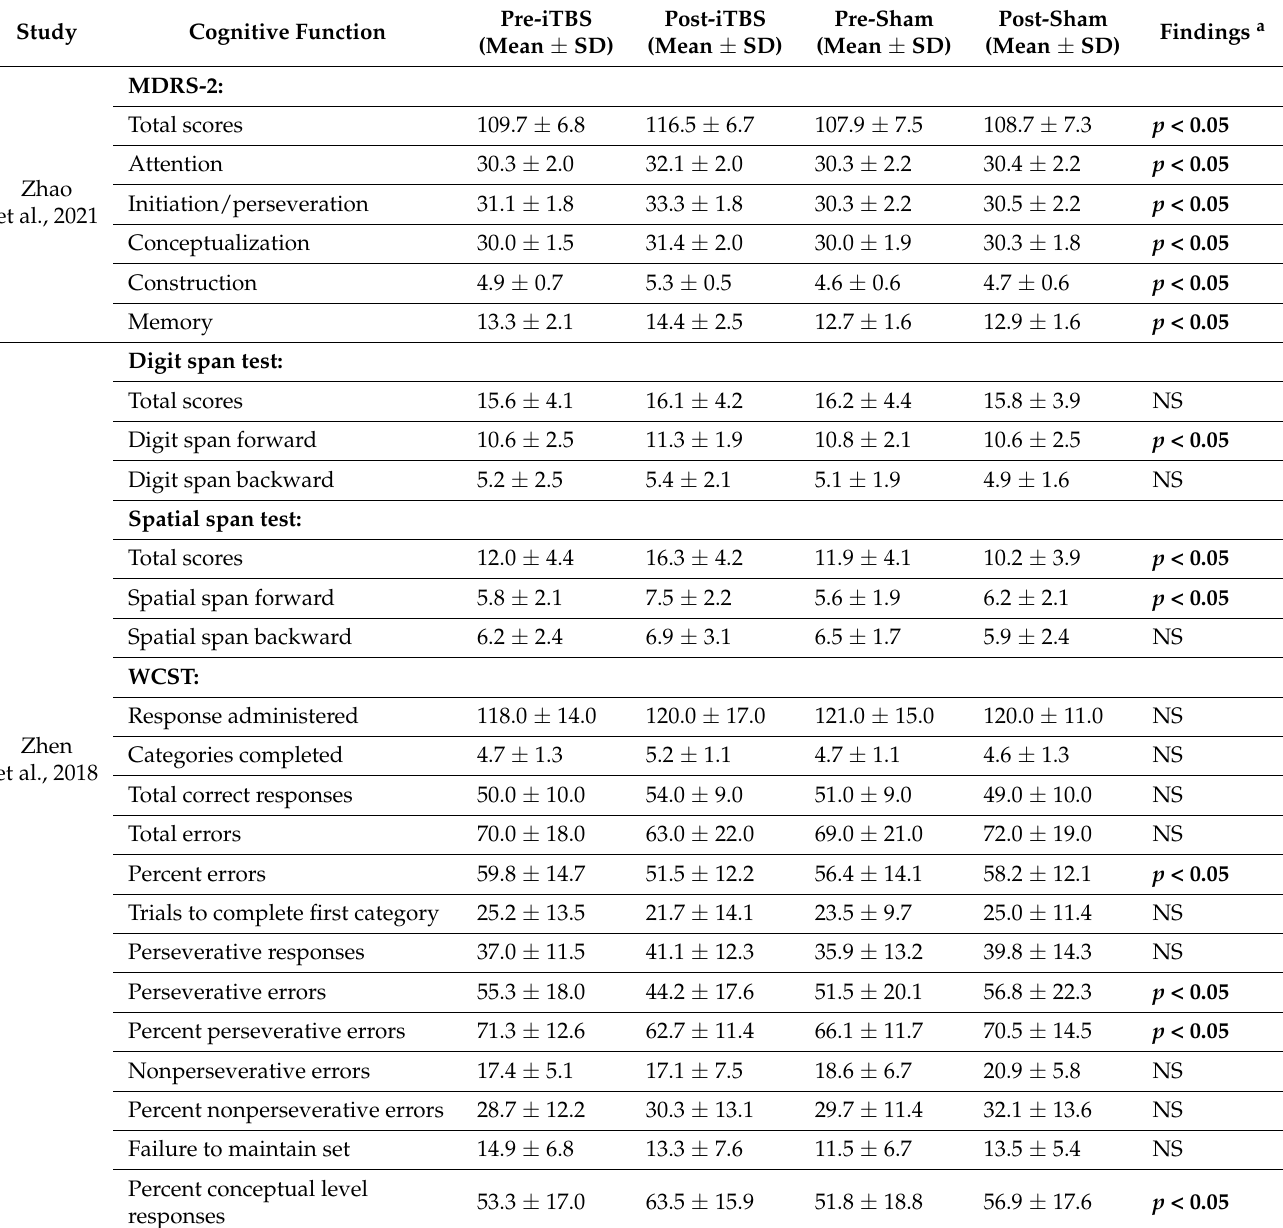
Table 2. Improvement in cognitive function after